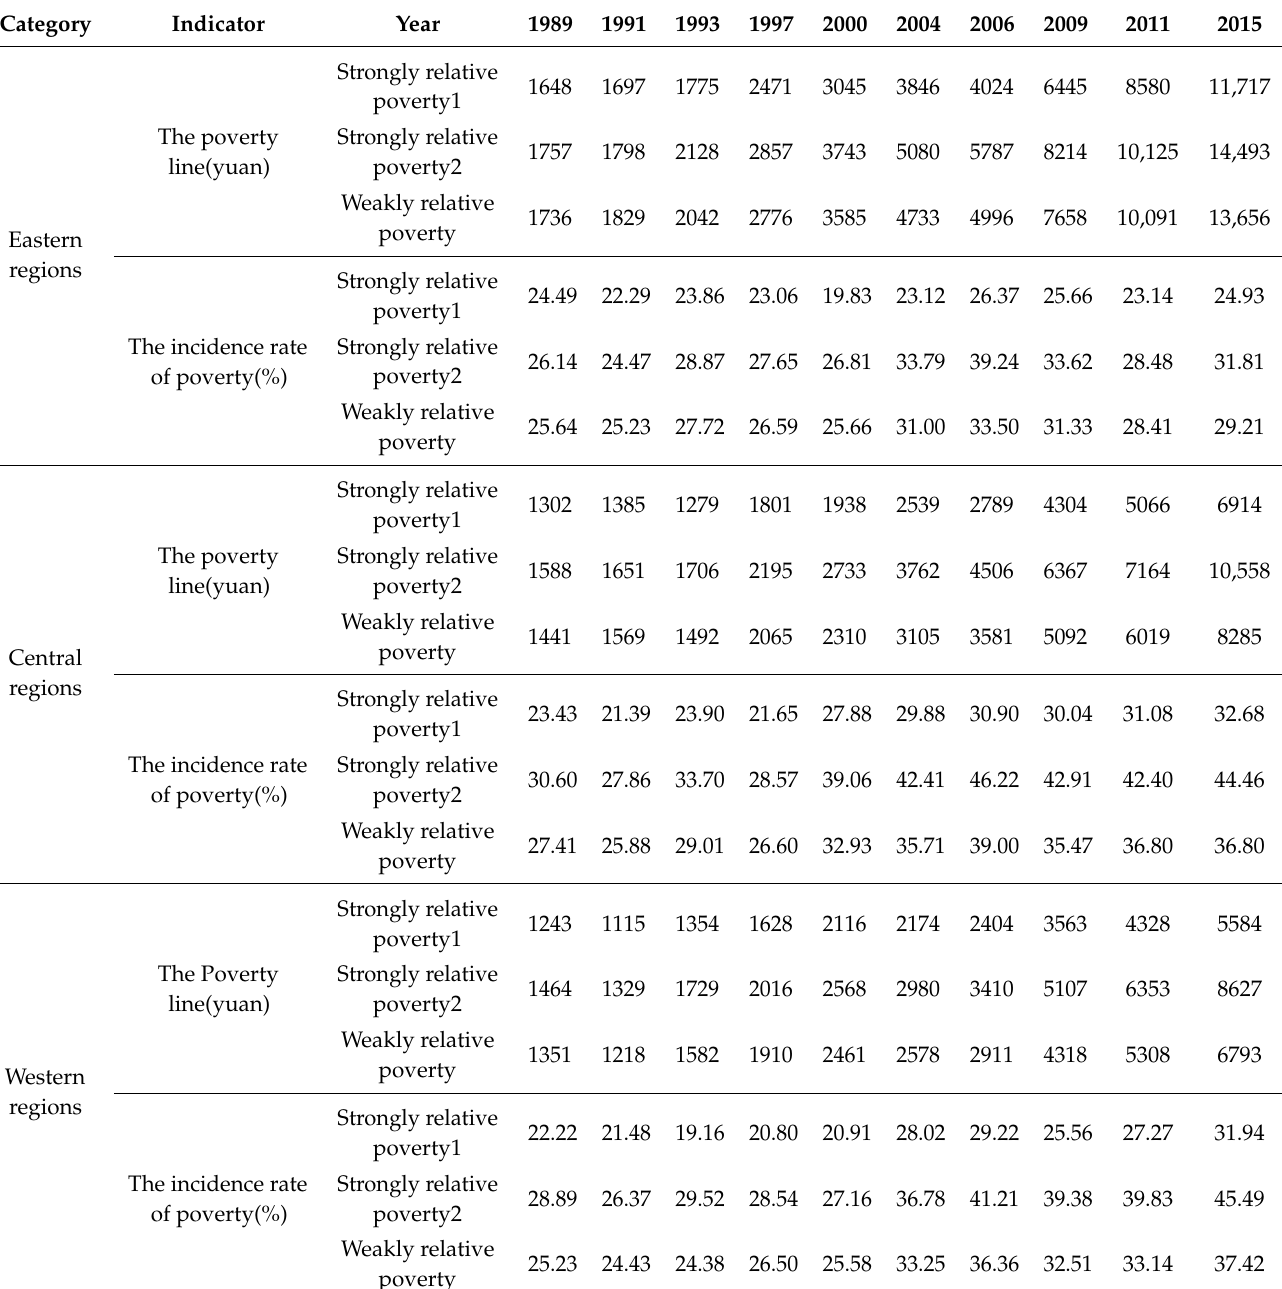
Table 5. Relative poverty of eastern, central, and western